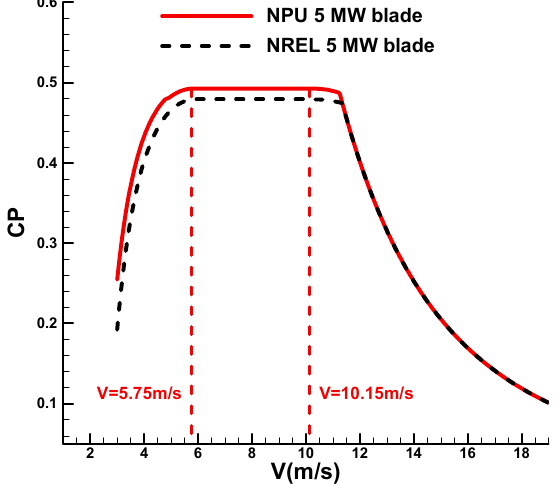
Figure 22. Comparison of wind speed (V)–power (P) for the NPU and NREL 5 MW blades.